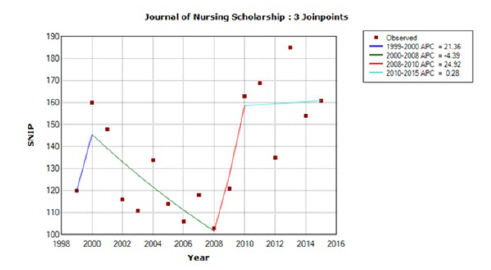
Figure 2 Trend model for the Journal of Nursing Scholarship (JNS)